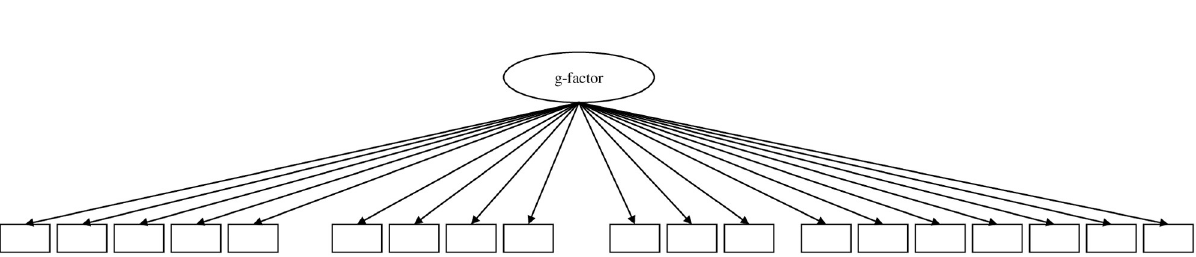
Fig 3. Hypothesized CFA model 3 of the MARS. Item-wise error variances are not represented in the models; correlations between errors were not allowed.